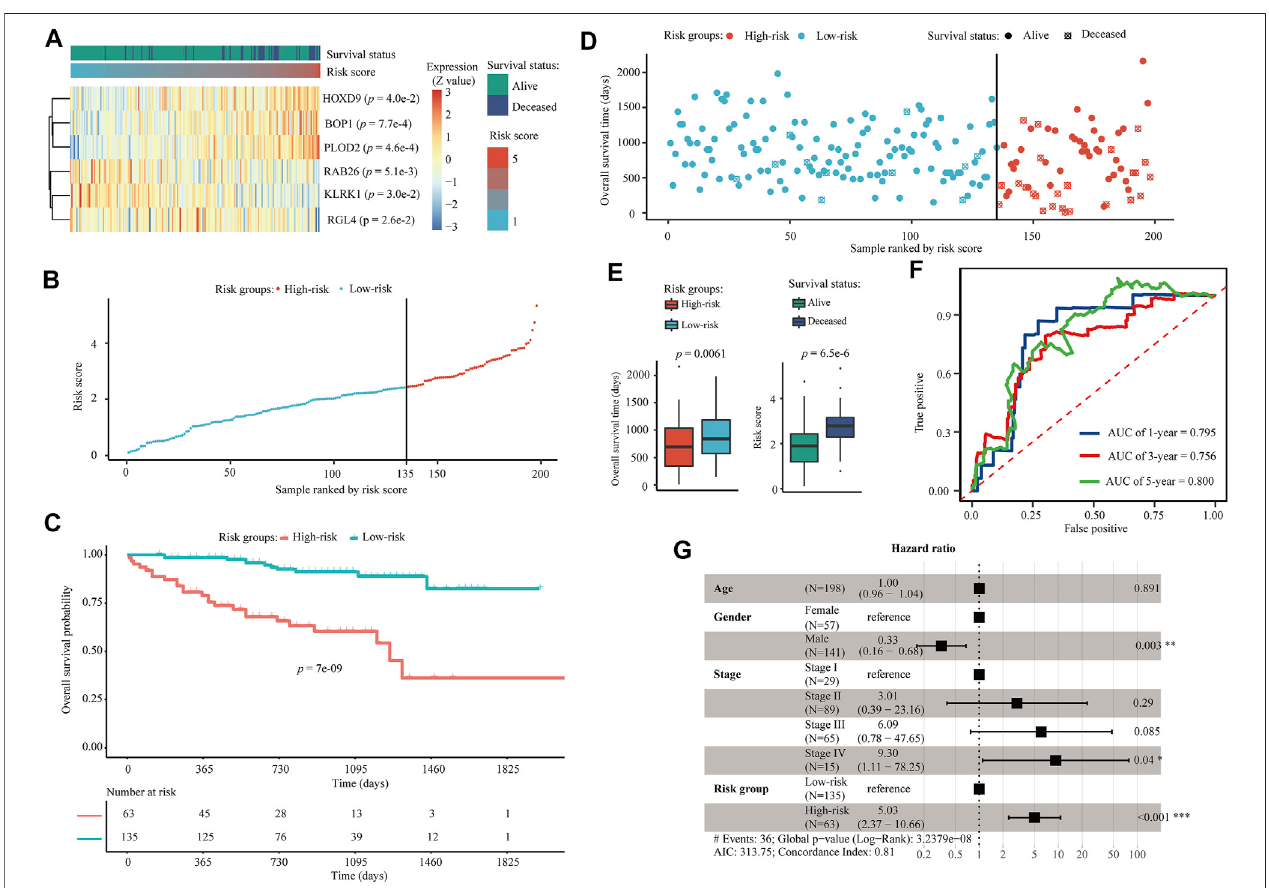
FIGURE9| ValidationofthesixAE-DEG-basedprognosticmodelforOSofHCCinICGC-LIRIcohort. (A) TheexpressionheatmapofsixAE-DEGsconstituted the identi fi ed prognostic model for overall survival of HCC in ICGC-LIRI cohort. Patients were ranked according to their risk scores. (B) Distribution of the calculated risk scores of HCC patients in ICGC-LIRI. (C) Kaplan-Meier analysis of the 6-gene prognostic signature in ICGC-LIRI. (D) Distribution of duration and survival status of HCC patients in ICGC-LIRI. (E) Boxplots display the comparison of survival time between high- and low-risk HCC patients and the comparison of risk score between alive and deceased HCC patients in ICGC-LIRI. (F) Time-dependent ROC analysis of the six AE-DEG-based prognostic signature in ICGC-LIRI. (G) Forest plot of the multivariate Cox regression analysis in ICGC-LIRI.